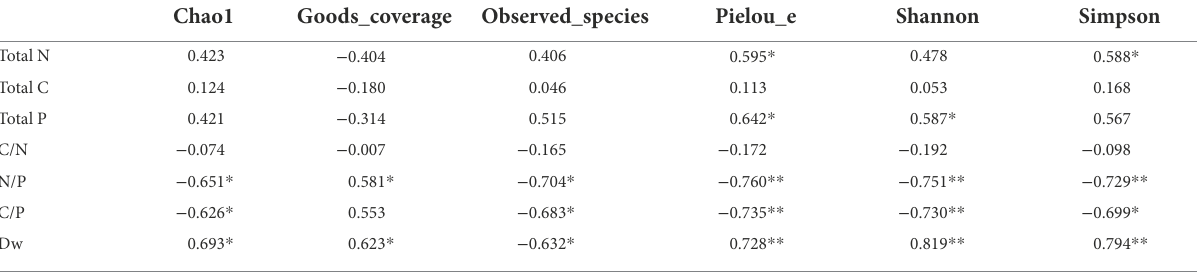
TABLE 2 Correlation between litter physicochemical properties and bacterial community diversity.